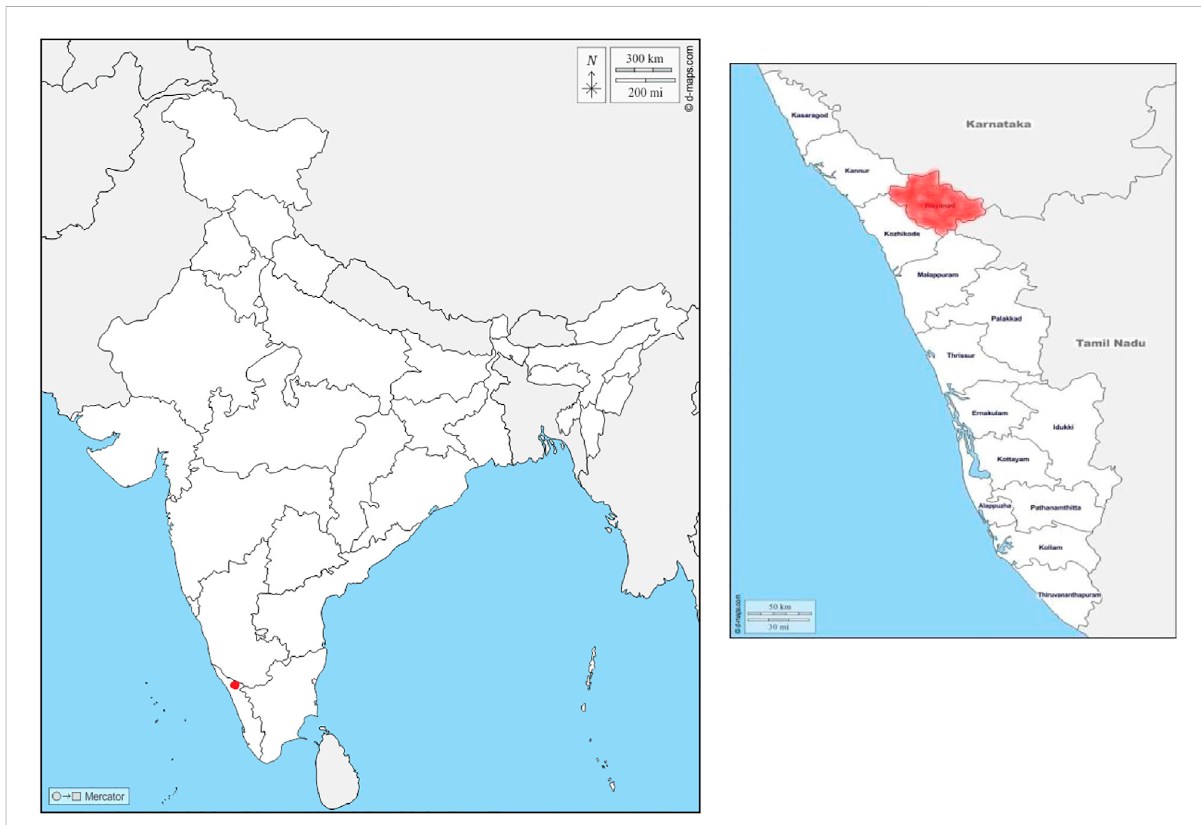
FIGURE 1 WayanadinKerala,India(ImageSources:https://d-maps.com/carte.php?num_car=4182&lang=en,https://d-maps.com/carte.php?num_car=